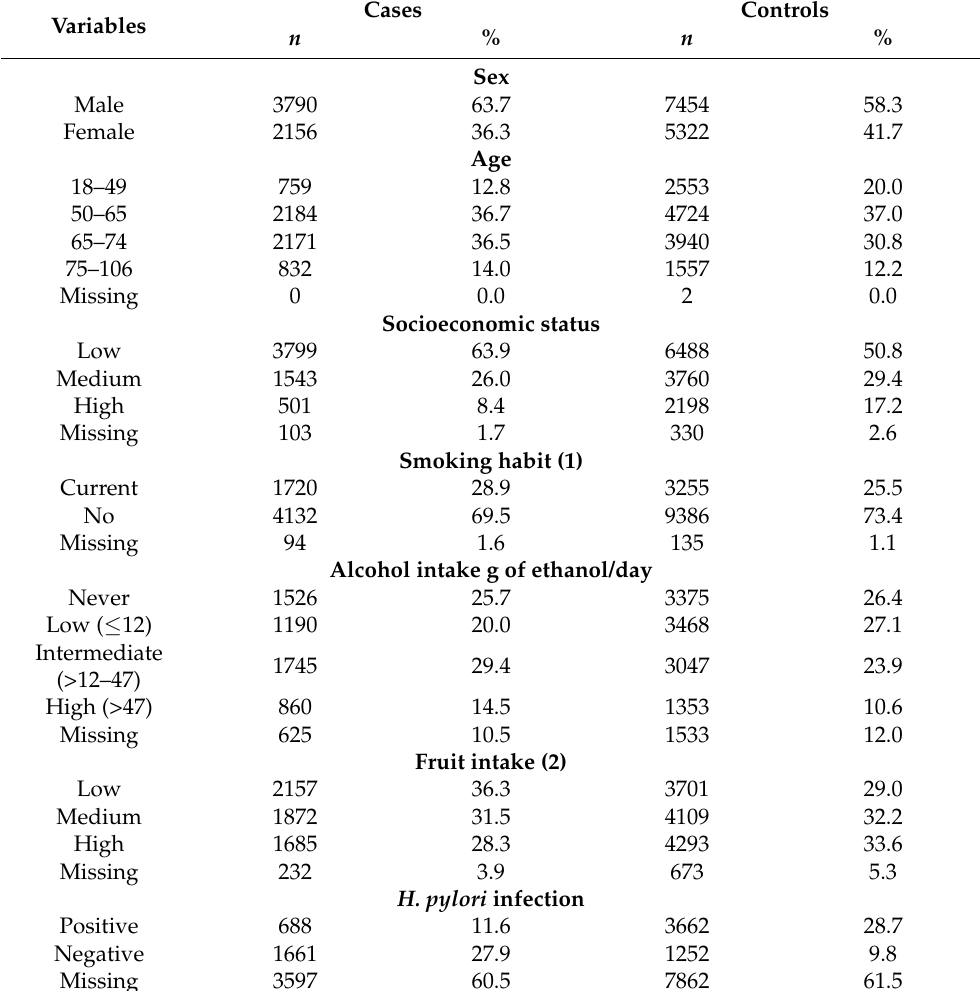
Table 2. Distribution of cases and controls according to selected